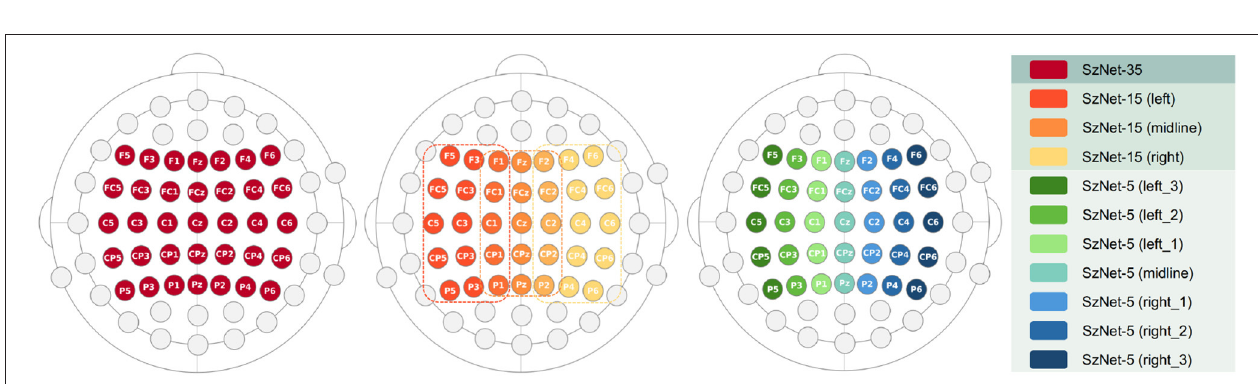
FIGURE 6 | Illustration of the electrode alignment in the 2D structure created for each EEG segment, and schematization of the convolutional process of the extra layer added to the SzNet-15 and SzNet-35 networks. K spatial represents the kernel used in the convolutional layer. N corresponds to the number of electrodes of each area